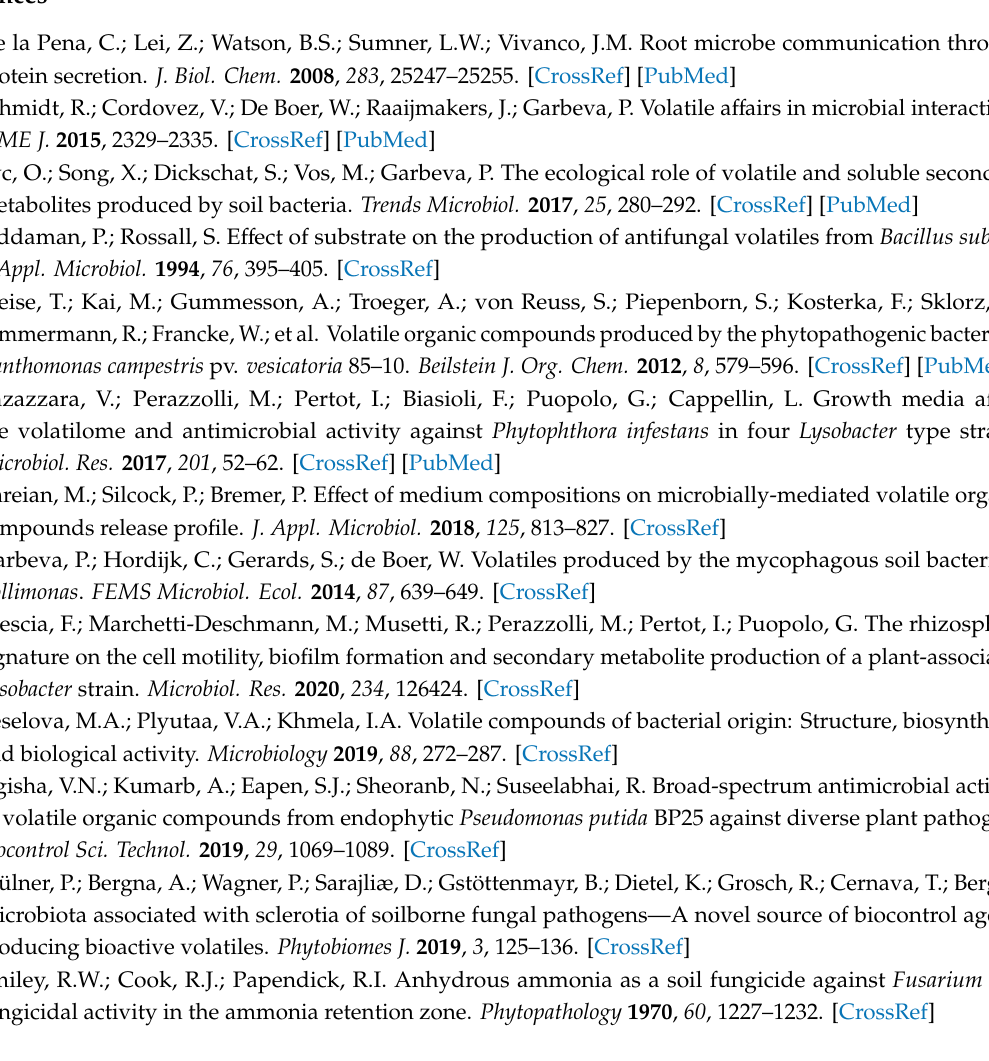
Table S1: DHS-TD-GC-MS analysis of split Petri dishes with Lysobacter capsici AZ78 cultures and PDA, Table S2: Involvement of basic volatiles produced by Lysobacter capsici AZ78 in the inhibition of Rhizoctonia solani growth, Table S3: PDA alkalinization as a result of Lysobacter capsici AZ78 basic volatile emissions, Figure S1: Production of basic volatiles by Lysobacter capsici AZ78 at 72 h incubation, Figure S2: Standard series of ammonia concentrations, Figure S3: Parallel chromatographic analysis (HS-GC-FID) of Lysobacter capsici AZ78 samples grown on NA medium (168 h) and synthetic